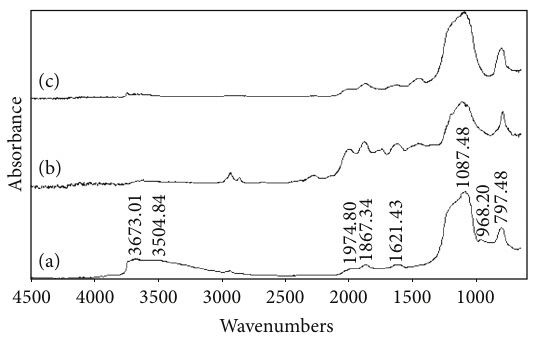
Figure 2: DRIFT spectra of (a) Si Na , (b) Si CNa , and (c) Si